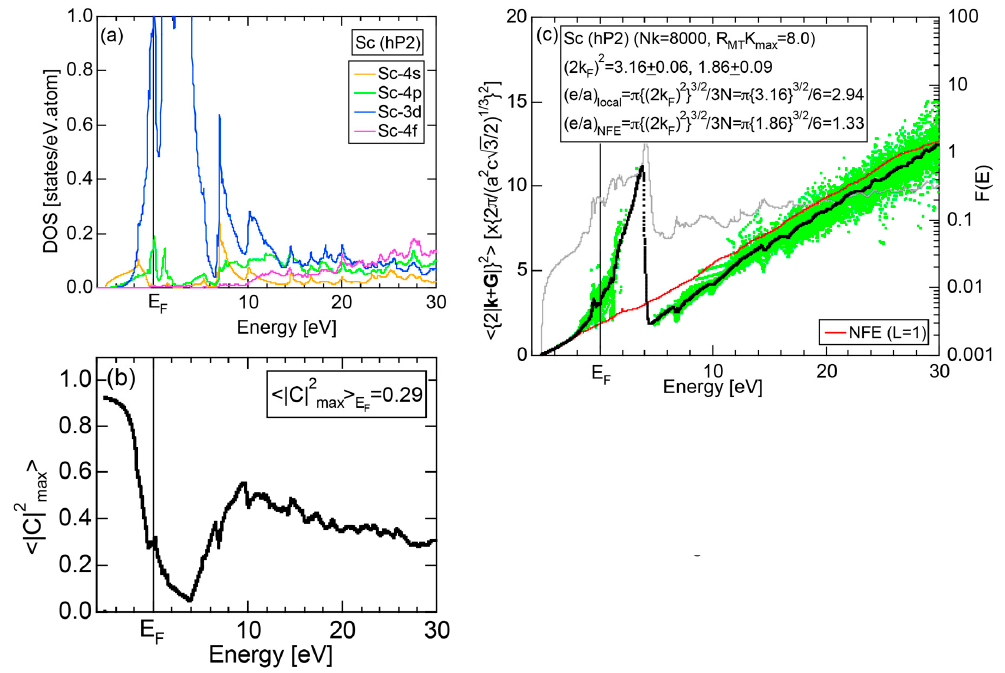
Figure 92. ( a ) Sc-partial DOSs, ( b ) C and ( c ) Hume-Rothery plot for Sc (hP2). See captions of Figure 19 (b) for symbols in (c) [11,15,16,37]. Two distinct e/a values are obtained for Sc (hP2), depending on either the local reading or the NFE method.